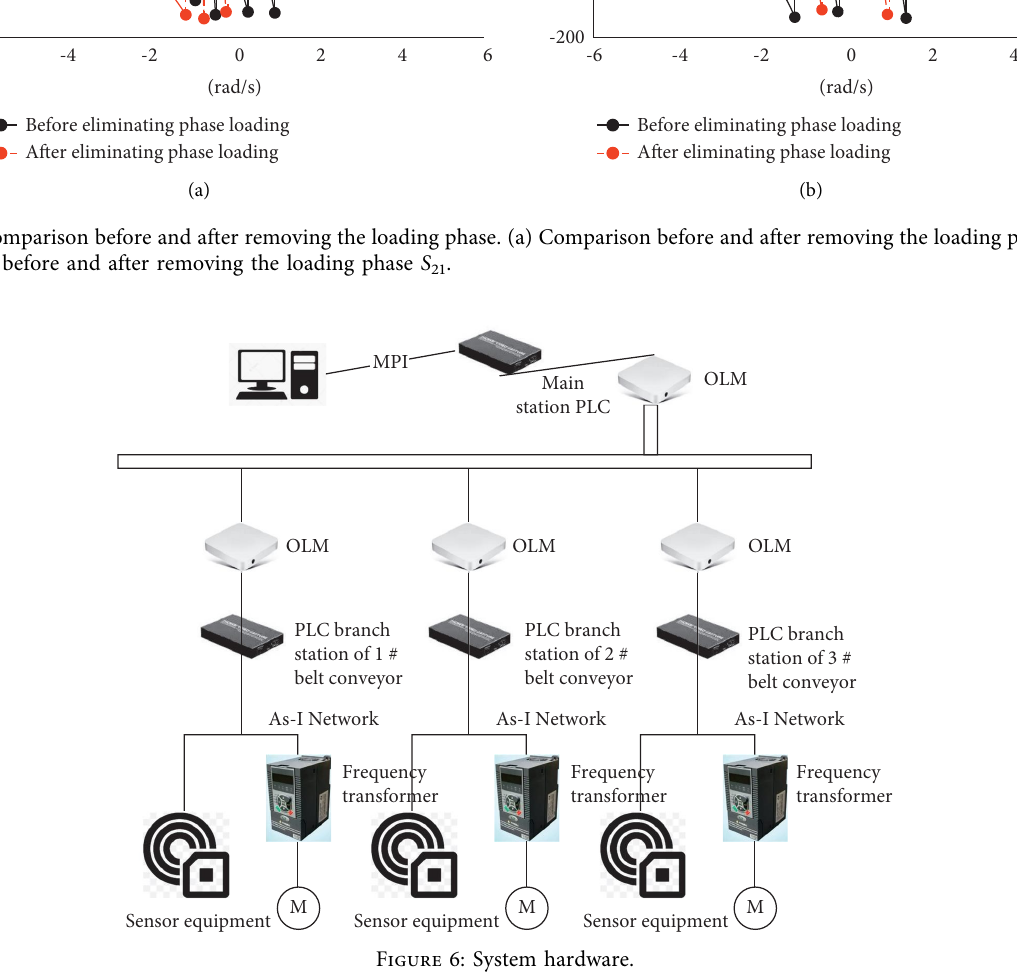
Figure 6: System